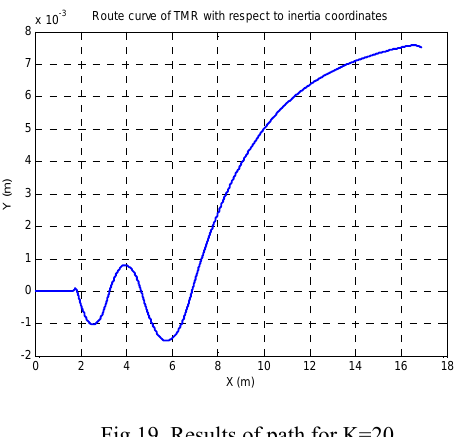
Fig.19. Results of path for K=20